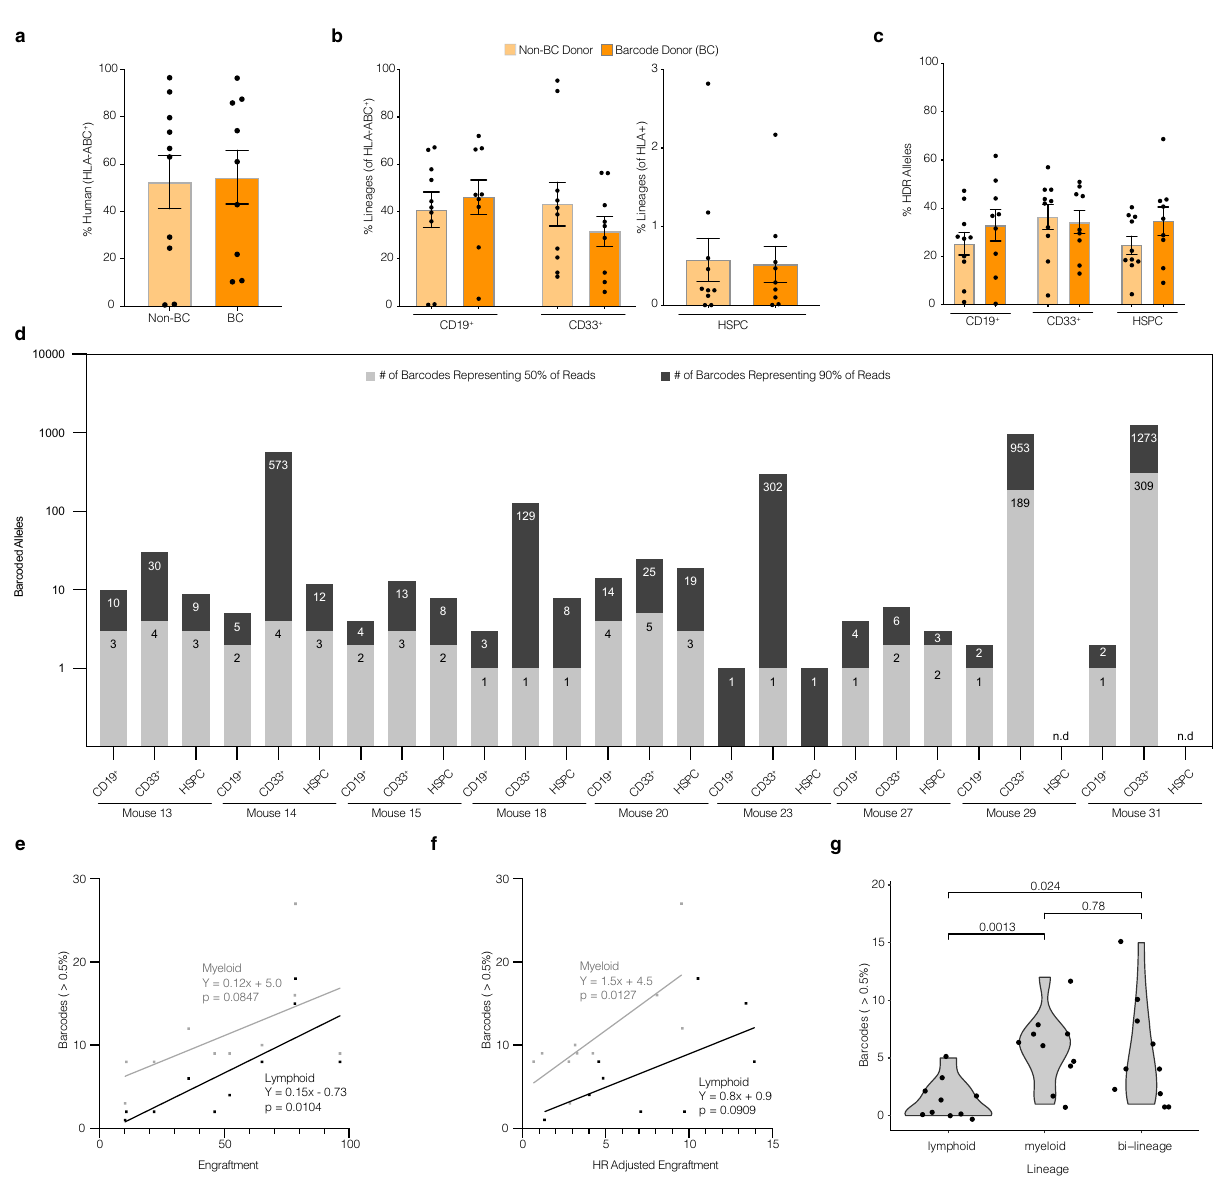
Fig. 3 TRACE-Seq identi fi es lineage-restricted and multi-potent gene-targeted HSPCs in primary NSG transplants. CD34 + enriched cord blood-derived HSPCs were cultured in HSPC media containing SCF, FLT3L, TPO, IL-6, and UM-171 for 48 h, electroporated with Cas9 RNP (HBB sgRNA), transduced with AAV6 donors (either BC or non-BC), and cultured for an additional 48 h prior to intrafemoral transplant into sublethally irradiated NSG mice (total manufacturing time was less than 96 h). A total of 16 – 18 weeks post-transplantation, total BM was collected and analyzed for engraftment by fl ow cytometry, sorted on lineage markers, and sequenced for unique barcodes. Two independent experiments were performed to assess reproducibility of identifying clonality of gene-targeted HSPCs. a Total human engraftment in whole bone marrow, (as measured by the proportion of human HLA-ABC + cells). b Multilineage engraftment of human CD19 + , CD33 + , and HSPCs (CD19 − CD33 − CD10 − CD34 + ). c Genome editing ef fi ciency in each indicated sorted human lineage subset as determined by NGS (HR reads/[all reads]). d Barcodes from each subset were sorted from largest to smallest by percentage of reads. Depicted are the numbers of most abundant, unique barcode alleles comprising the top 50% and top 90% of reads from each lineage of all mice transplanted with BC donor edited HSPCs. Mean± SEM genomes analyzed from each group: CD19 + : 8500 ± 1000, CD33 + : 8800 ± 800, HSPC: 1500 ± 500 (see Supplementary Table 4). e Correlation between numbers of high con fi dence barcodes (>0.5%) in lymphoid (gray) and myeloid (black) compartments and total human engraftment (as percent of human and mouse BM-MNCs). Lymphoid and myeloid values plotted for n = 9 primary engrafted mice and n = 1 secondary engrafted mouse. f Correlation between numbers of high con fi dence barcodes (>0.5%) in lymphoid (gray) and myeloid (black) compartments and HR adjusted engraftment ([human engraftment] x [lineage speci fi c engraftment] x [HR ef fi ciency]). Lymphoid and myeloid values plotted for n = 9 primary engrafted mice and n = 1 secondary engrafted mouse. g Numbers of high con fi dence barcodes from each mouse which contribute to lymphoid only (CD19 + ), myeloid only (CD33 + ), or both lineages. High con fi dence barcodes: barcodes with at least 0.5% representation (see Supplementary Fig. 1). All points represent individual mice ( n = 9 non-BC treated and n = 10 BC treated biologically independent mice in one independent experiment), with the exception of panels e – g (where barcodes from each mouse are separated based on lineage contribution). Error bars depict mean ± SEM. p values re fl ect 2-tailed